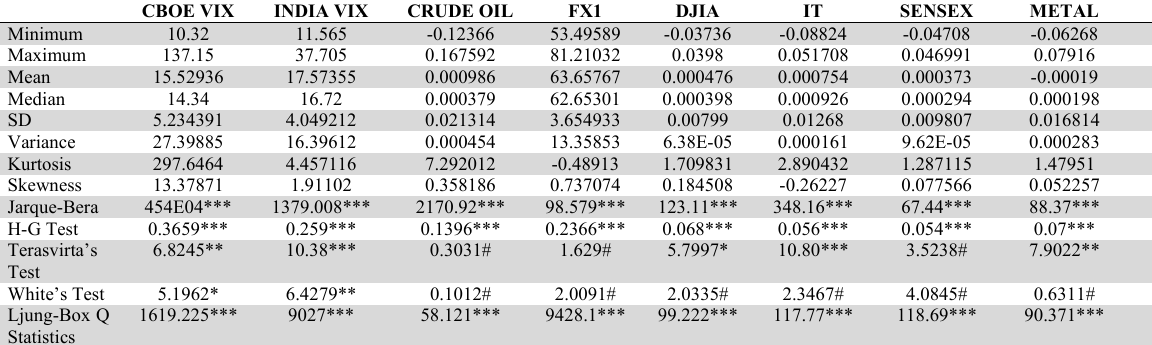
Table 1 Statistical summary of concerned series CBOE VIX